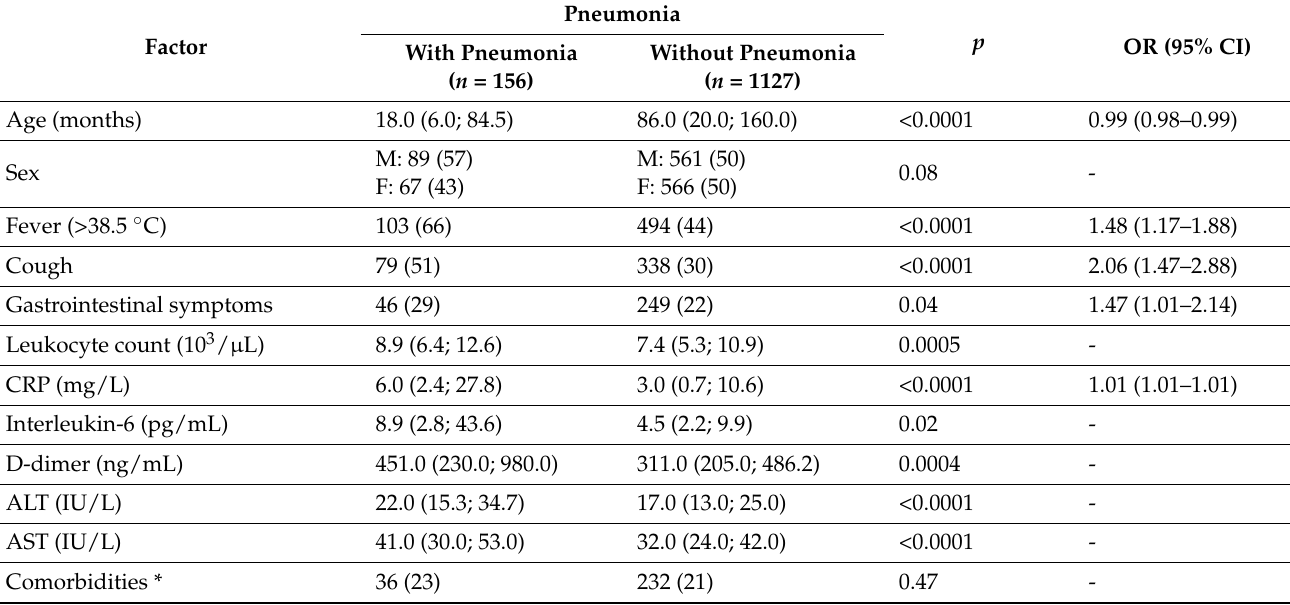
Table 2. Clinical factors associated with COVID-19-related pneumonia.